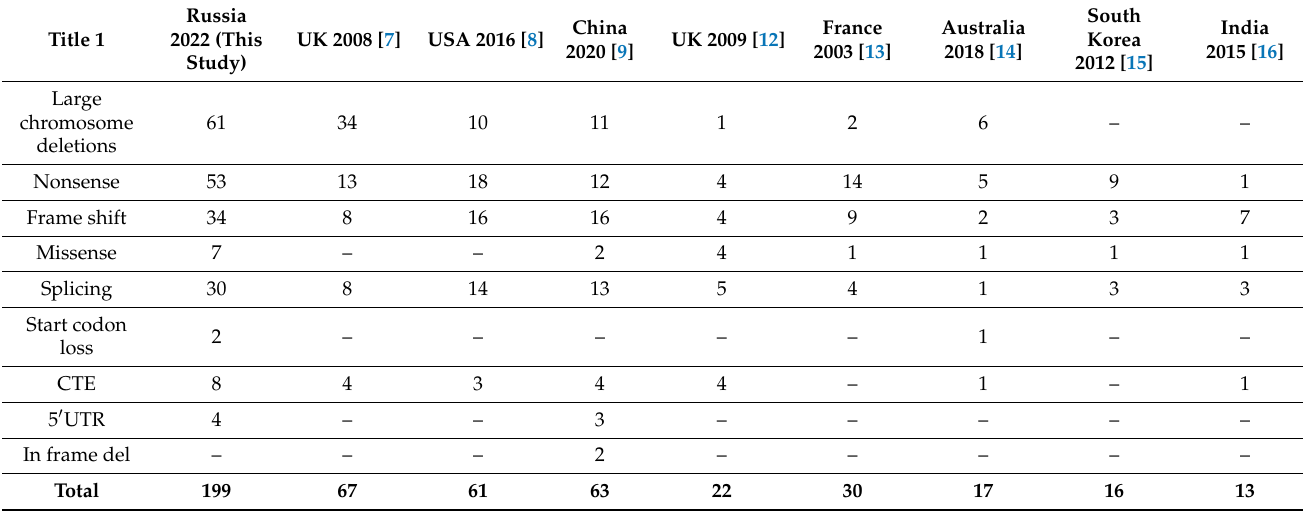
Table 1. Comparison of PAX6 mutation types in world-wide cohorts of aniridia